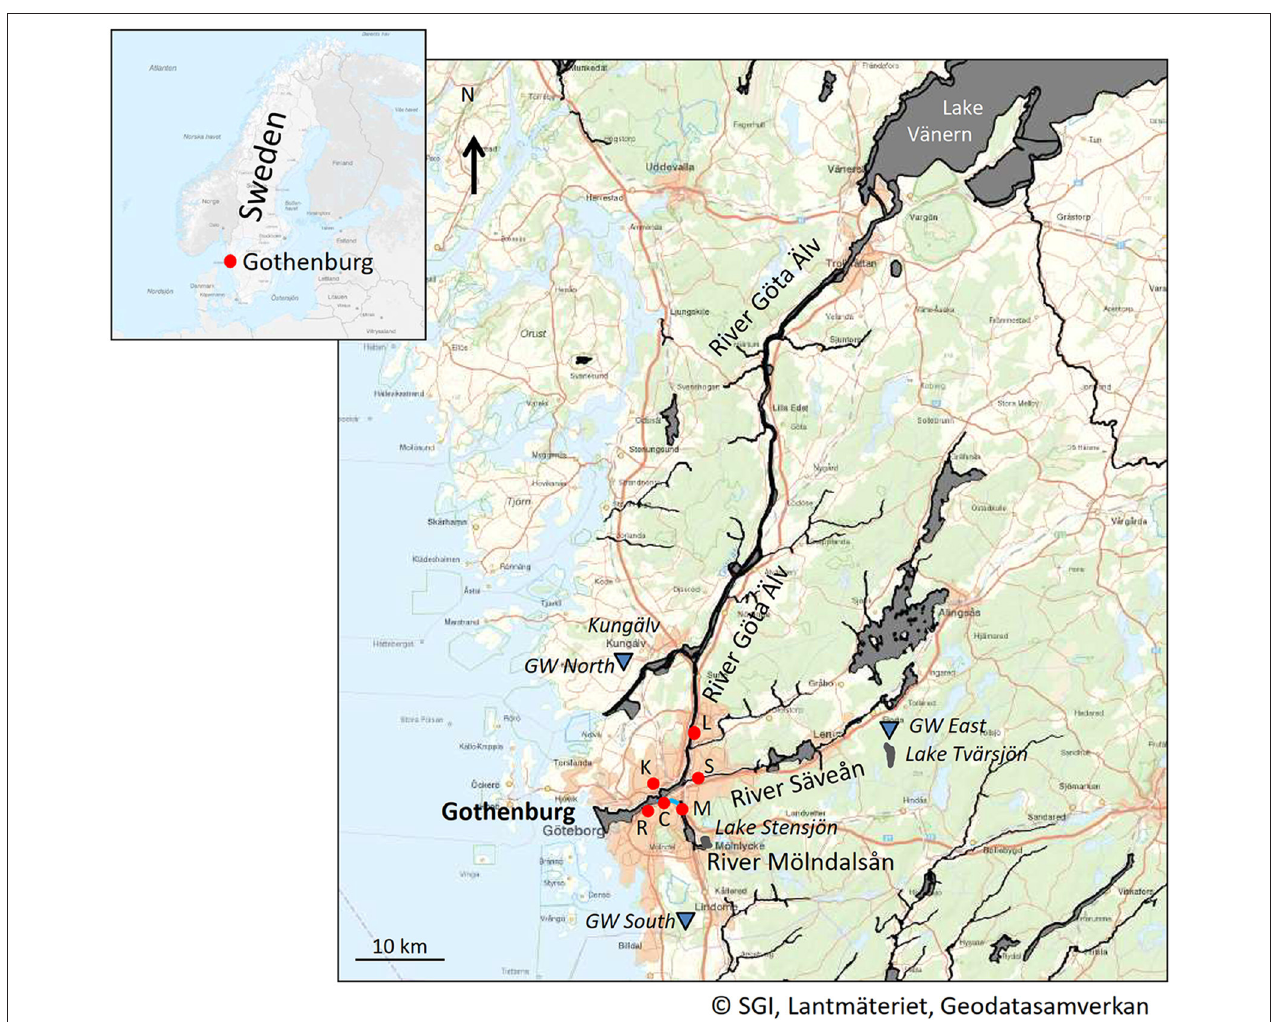
FIGURE 1 | City of Gothenburg, Sweden, showing the sampling sites for surface water sampling, the lakes Tvärsjön and Stensjön, and three groundwater monitoring wells. Sampling site L, Lärjeholm; S, Säveån; M, Mölndalsån; K, Kvillebäcken; C, City Canal; R, Röda Sten. © SGI, Lantmäteriet,